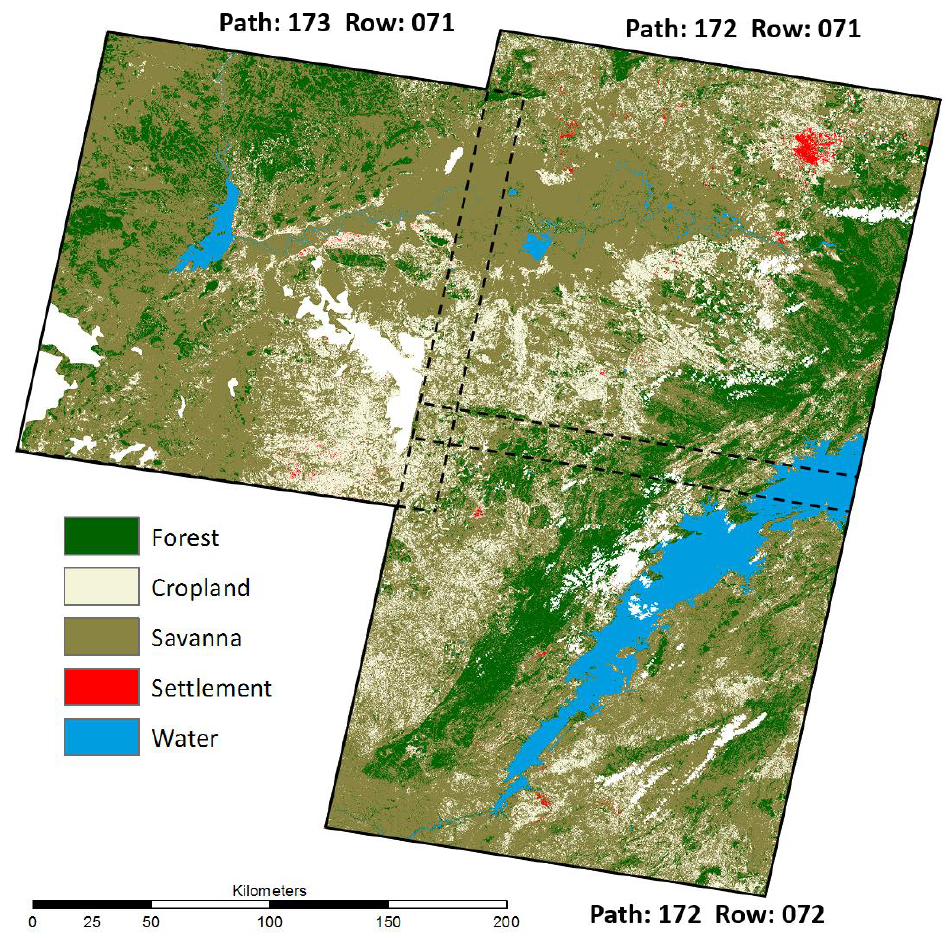
Figure 5. Thematic land cover map of combined scenes at Path: 172 Row: 071, Path: 172 Row: 072, and Path: 173 Row: 071. White areas were obscured by